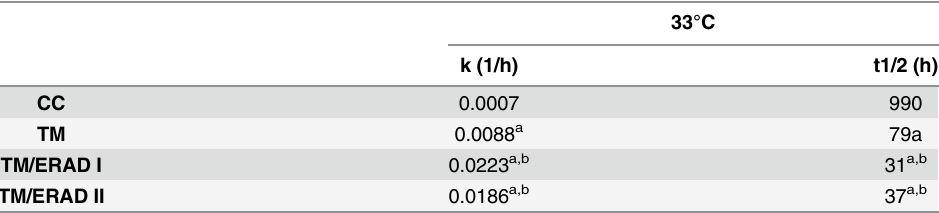
Table 1. Intracellular rht-PA half-accumulation time and accumulation constants under mild hypo- thermia and glycosylation/ERAD inhibition in the batch culture. 33°C k (1/h) t1/2 (h) CC 0.0007 990 TM 0.0088 a 79a 37 a,b